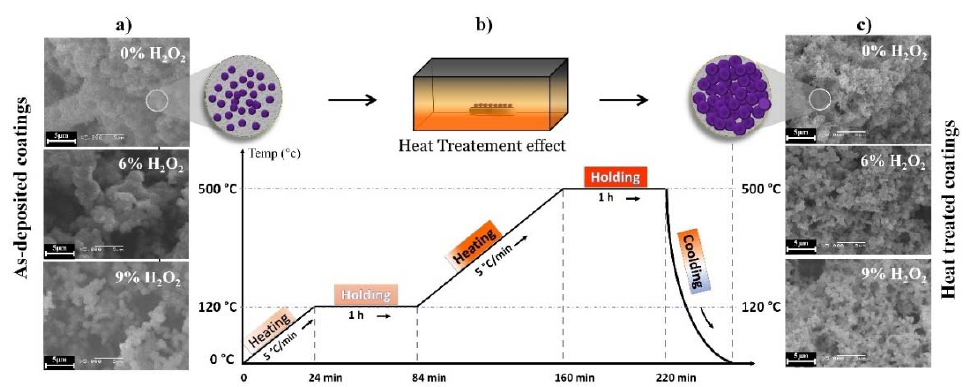
Figure 4. SEM micrograph of HAP coatings with various H 2 O 2 concentrations: ( a ) before heat treatment, ( b ) heat treatment protocol and ( c ) after heat treatment.